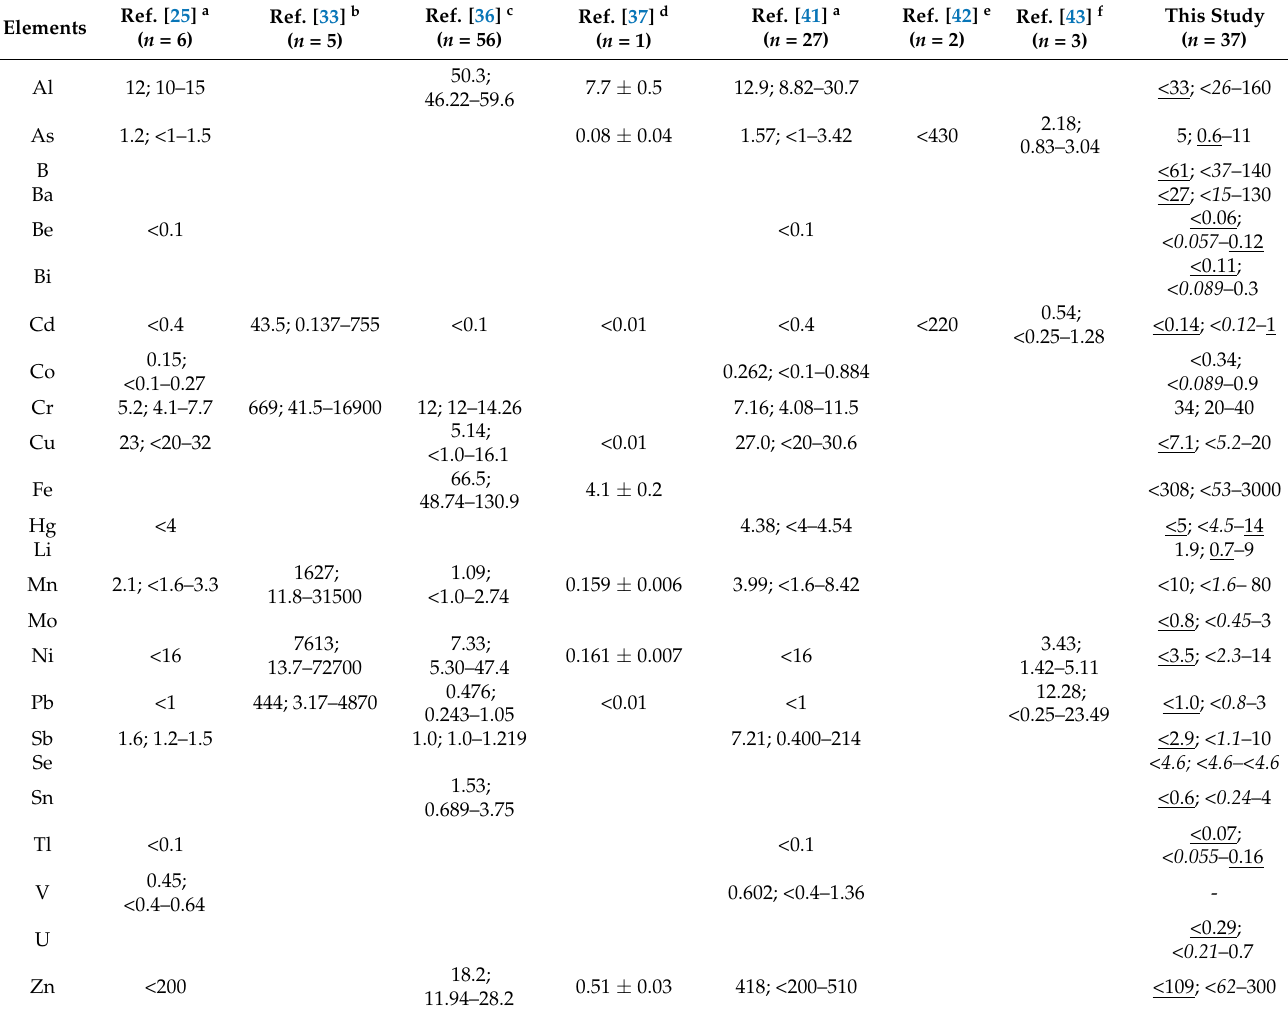
Table 4. Average amounts and ranges (in µ g kg − 1 ) of elements of health concern in e-liquids. Concentration was measured by means of ICP-MS